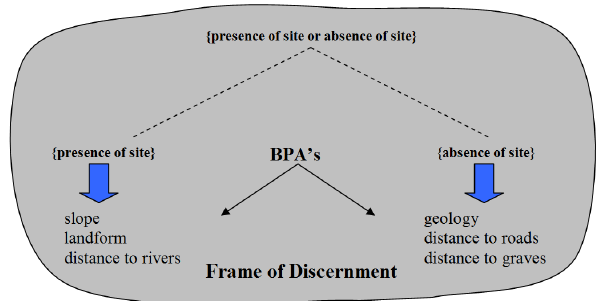
Figure 3. Frame of Discernment with the single hypothesis and their supporting